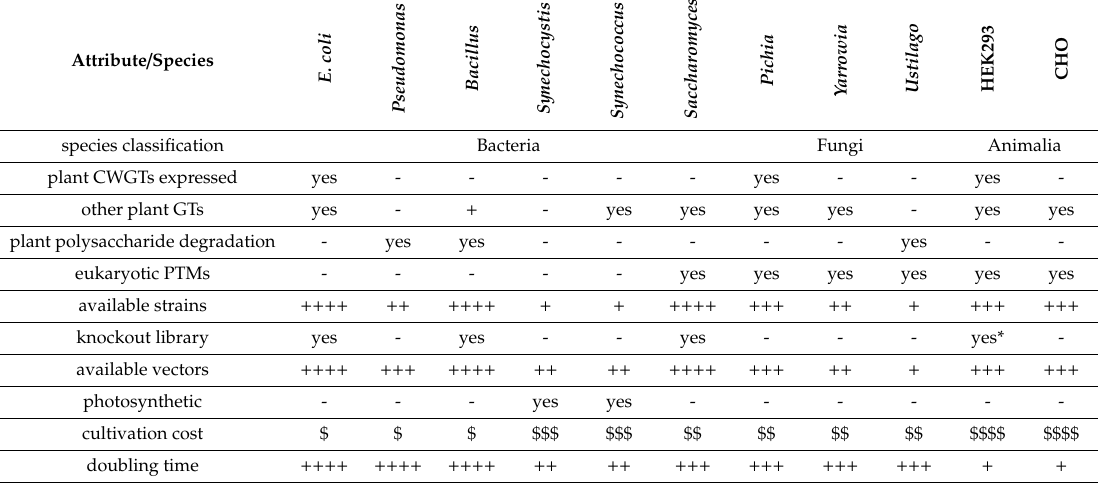
Table 1. Summary of the tools available for polysaccharide production in di ff erent host organisms. For each species, a relative ranking for di ff erent attributes is shown: handling, from least ( + ) to most convenient ( ++++ ); and price, from cheap ($) to most expensive ($$$$). The relative number of strains and vectors available to order were checked at AddGene (www.addgene.org), ATCC (www.atcc.org), DSMZ (www.dsmz.de), Invitrogen, and Sigma-Aldrich. Cultivation costs were based on the complexity of media used, the relative price of components at Sigma-Aldrich, and for the type of incubator used. Doubling times (20 min to 24 h) were estimated based on work by Pichia [30], Yarrowia [31], Ustilago [32], Pseudomonas [33], Bacillus [34], Synechocystis [35], Synechococcus [36], and DSMZ (other species). The knockout libraries for di ff erent hosts have been generated and are ready to order from AddGene, Dharmacon or AcceGen. The asterisk (*) indicates that the HEK293 mutant collection is not as comprehensive as the rest. “-“ – not described; E.coli—Escherichia coli DB3.1; Pseudomonas fluorescens ; Bacillus subtilis ; Synechocystis PCC 6803: Synechococcus elongatus sp. PCC 7942;